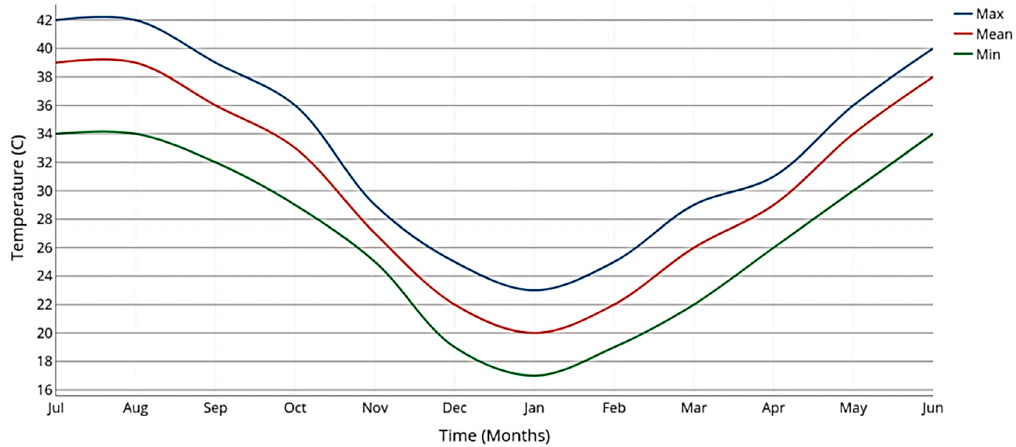
Figure 5. Seasonal temperatures in Doha, Qatar, from July 2017 to June 2018 [40].